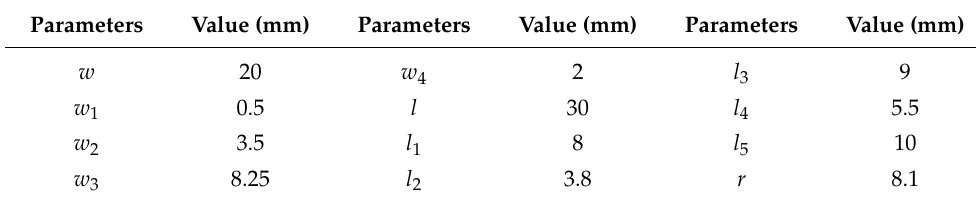
Table 1. Design parameters of the wearable antenna. Parameters Parameters